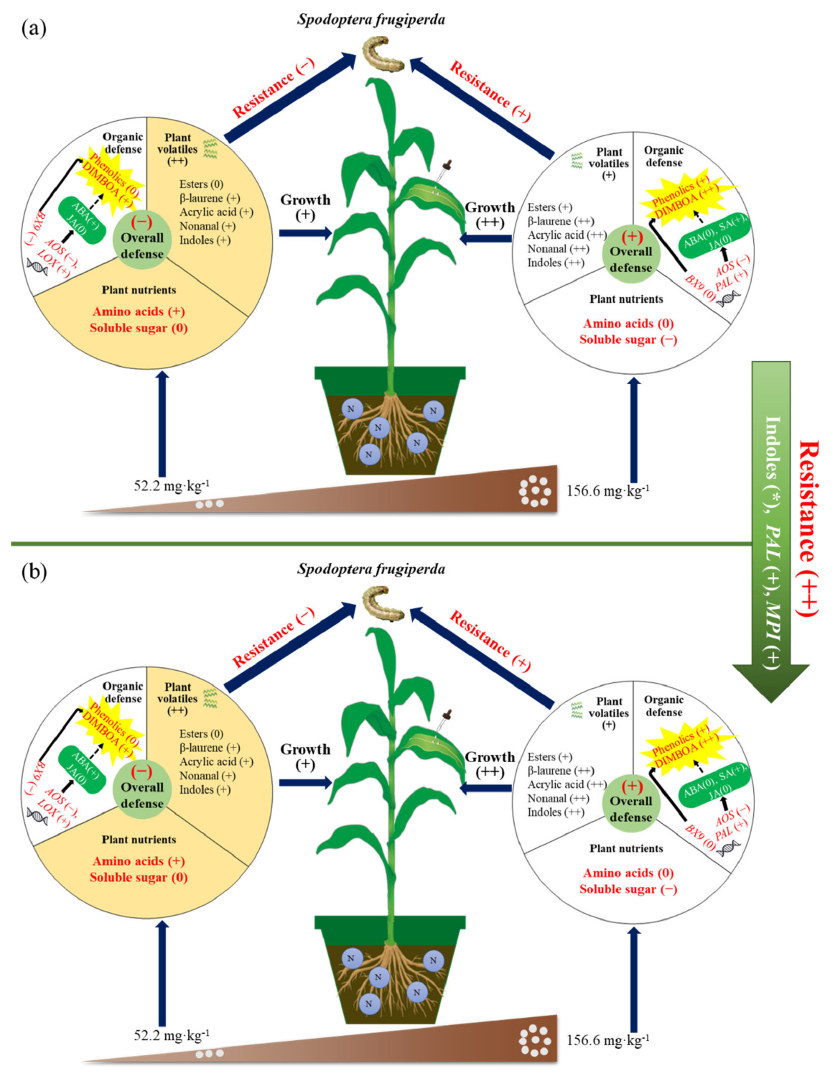
Figure 7. Mechanisms of N supply affecting the induced defense against S. frugiperda larvae. ( a ) For herbivore attack treatment; ( b ) for JA application treatment. The plus sign (+) indicates the enhanced insect resistance of maize, the increased content of chemicals (volatiles, metabolites and phytohormones), and the upregulated expression of genes. Two (++) plus signs indicate stronger effects. The minus sign (–) indicates the weakened insect resistance of maize, the reduced content of chemicals (volatiles, metabolites and phytohormones), and the downregulated expression of genes. “0” indicates no changed measured parameters. “*” indicates that the volatiles that are unique to maize plants.